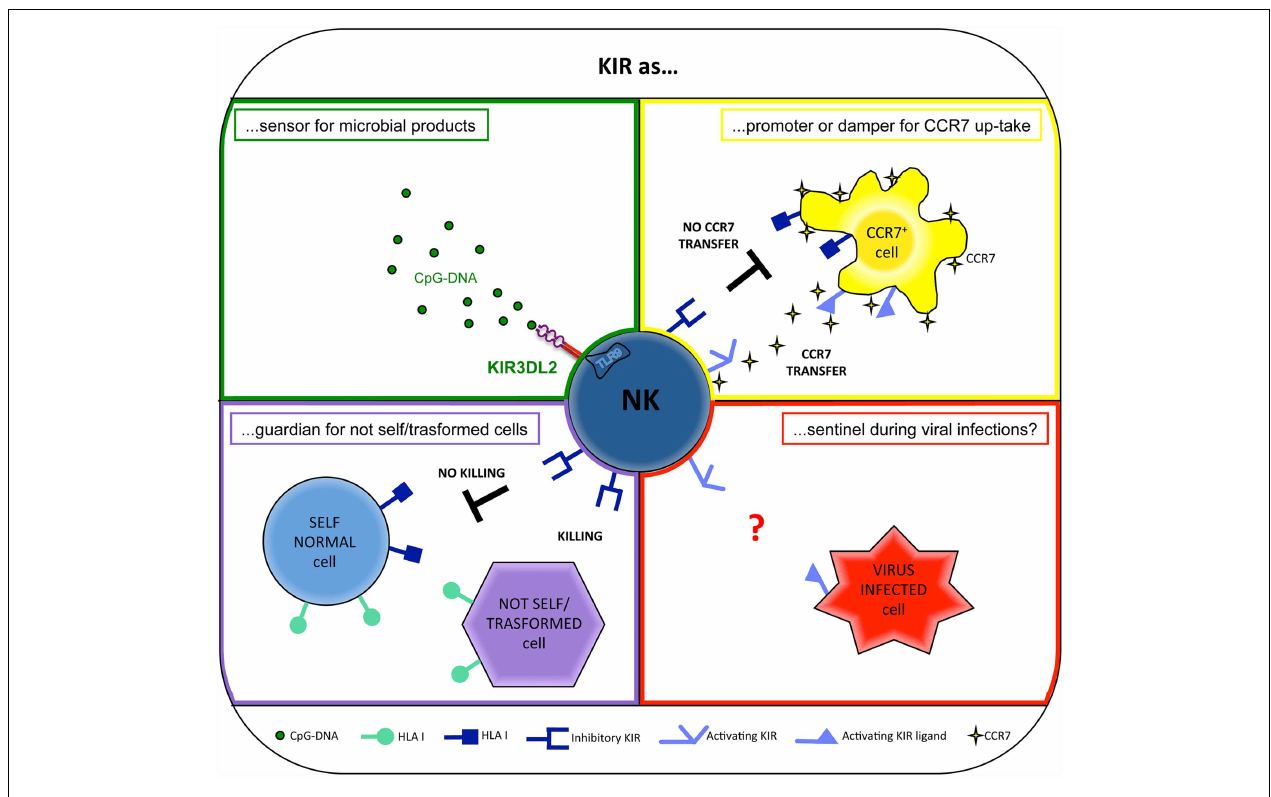
FIGURE 1 | Different roles for KIRs